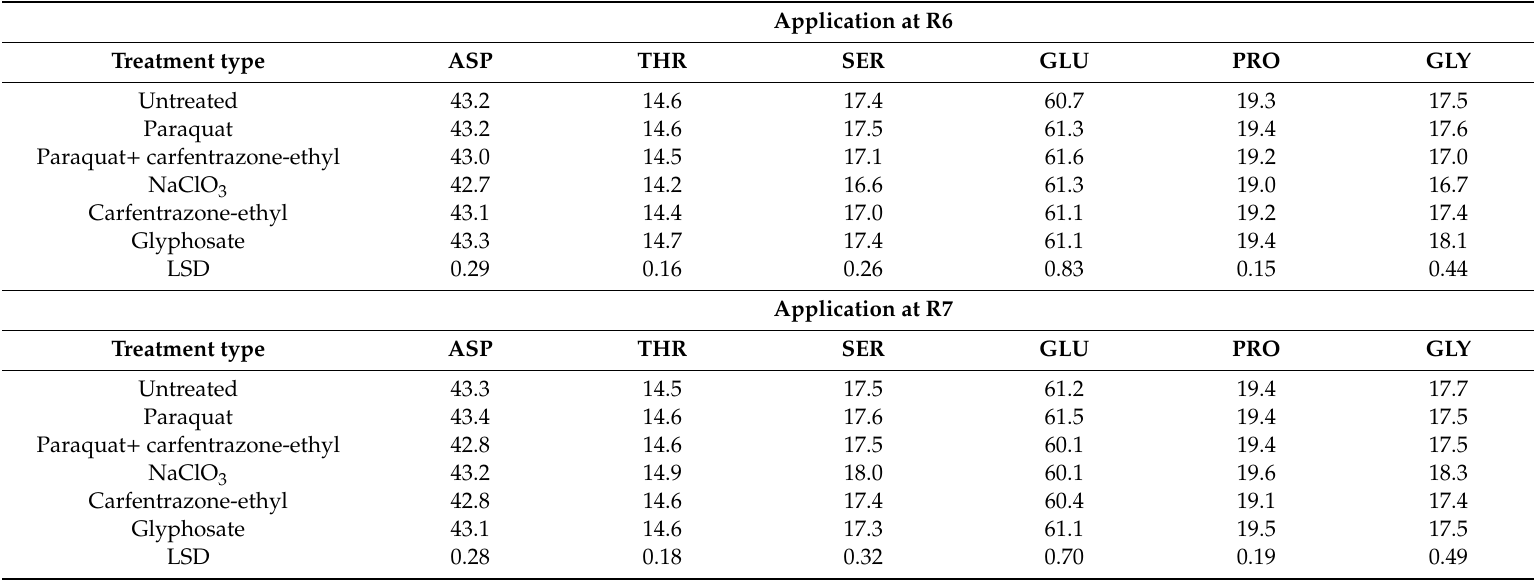
Table 5. E ff ects a of harvest aids (treatments: paraquat, paraquat + carfentrazone-ethyl, carfentrazone-ethyl, NaClO 3 , glyphosate) on seed amino acids asparagine (ASP), threonine (THR), serine (SER), glutamine (GLU), proline (PRO), and glycine (GLY) (mg g − 1 ) across two years. Untreated plants were used as the control. Harvest aids were applied at growth stages R6 and R7. The experiment was conducted in 2012 and 2013 in Stoneville,